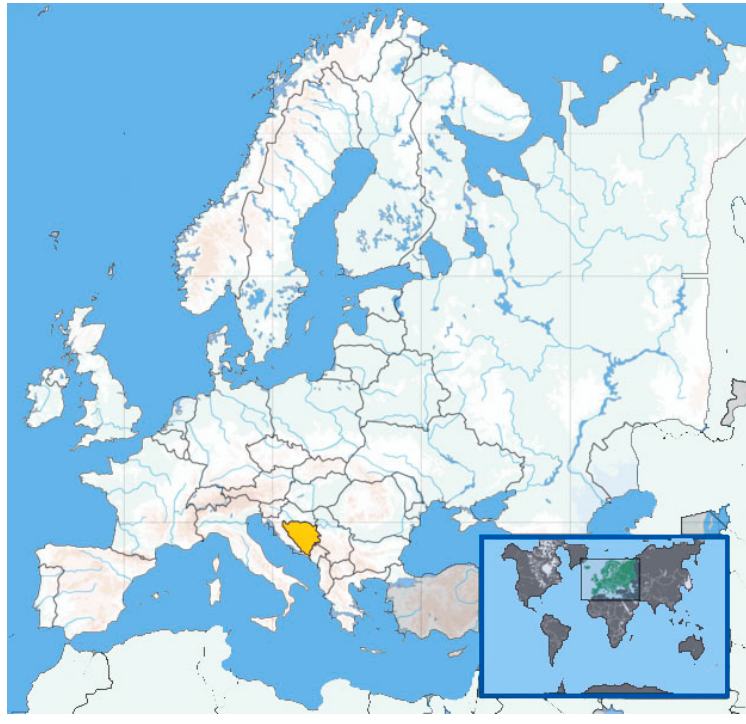
Figure 2. Position of BiH on the map [11].